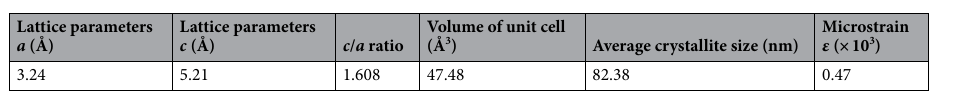
Table 1. Structural parameters of ZnO